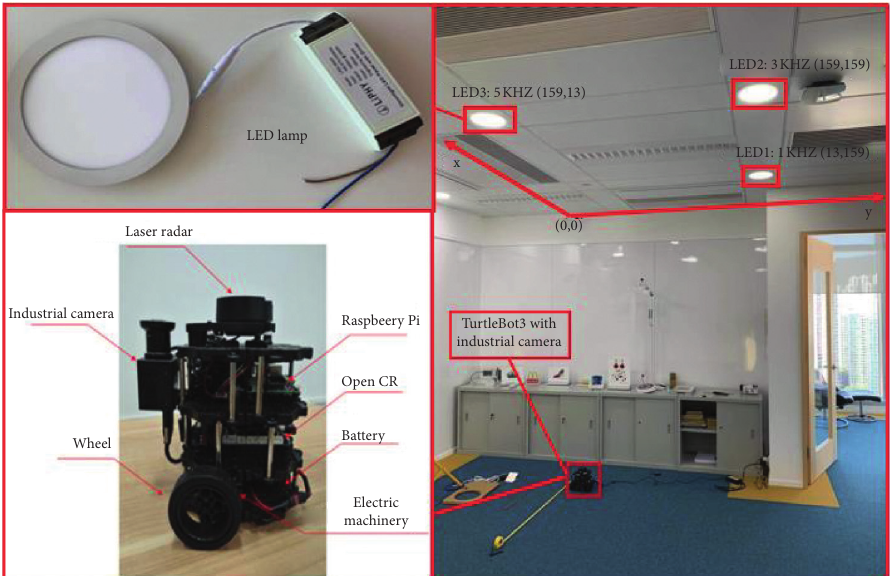
Figure 9: VLP-based system implementation platform.